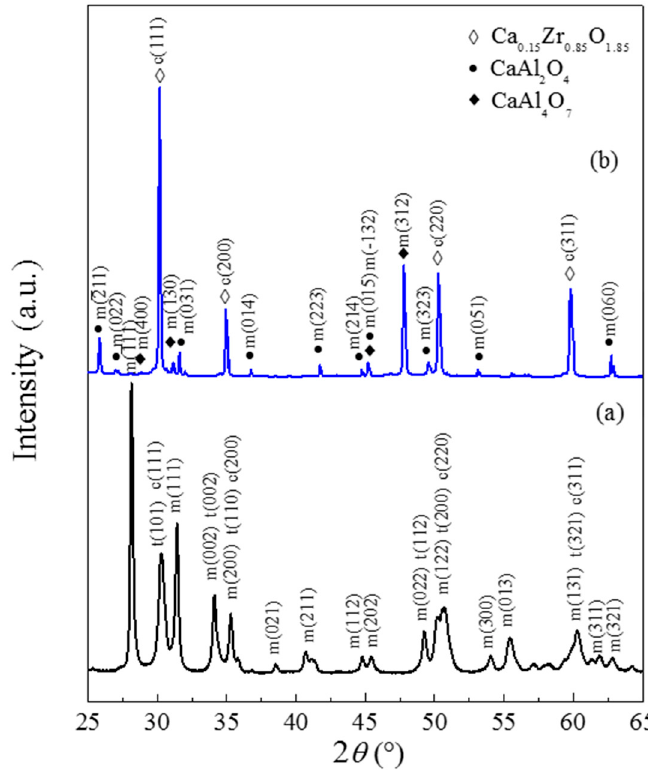
Figure 2. X-ray diffraction (XRD) patterns of the samples ( a ) before and ( b ) after laser